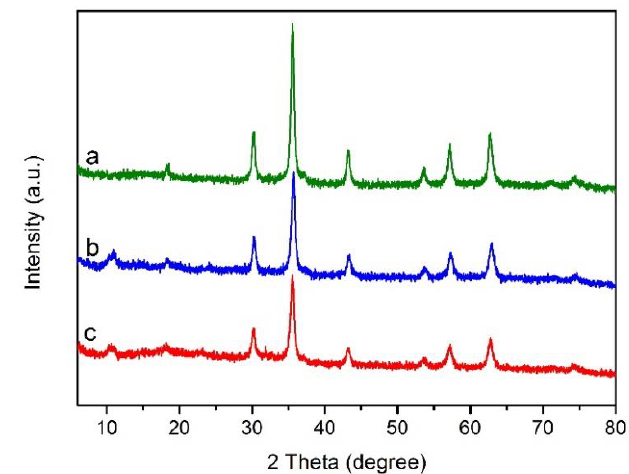
Figure 5. XRD patterns for Fe 3 O 4 microsphere ( a ), Fe 3 O 4 @MIL-100 (Fe) support ( b ), and the immobilized lipase ( c ).